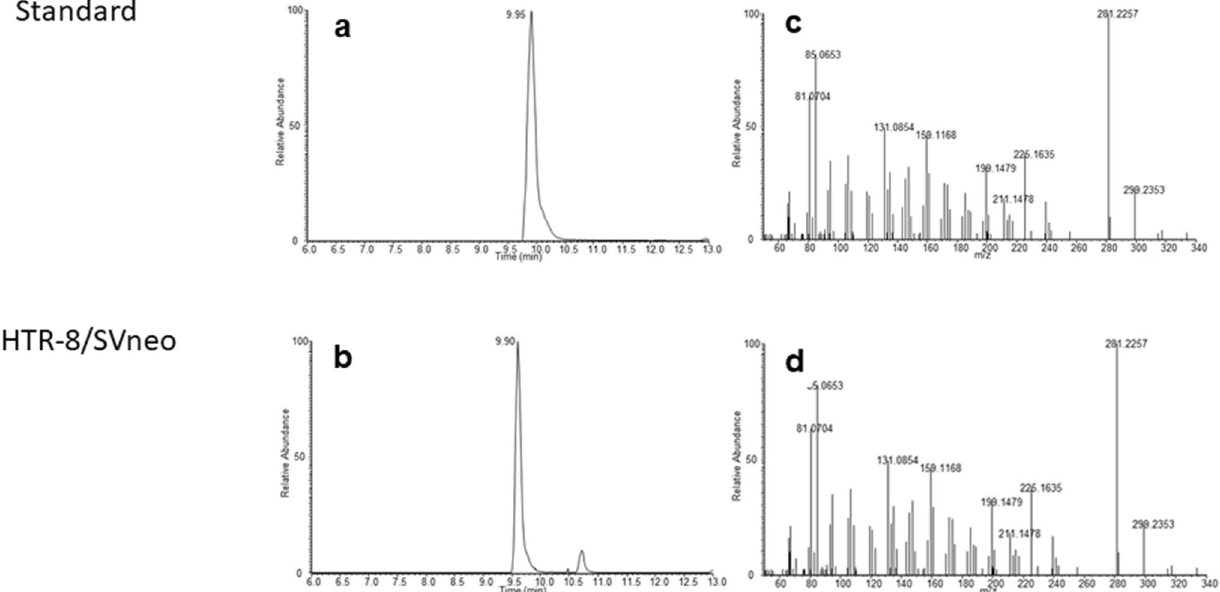
Figure 2. Identification of 6α-OH-pregnanolone by LC–MS/MS in HTR-8/SV neo cells: LC–MS trace of m/z 317.2469 corresponding to a sum formula of C 21 H 34 O 3 in an authentic standard ( a ) and in HTR-8/SV neo cells